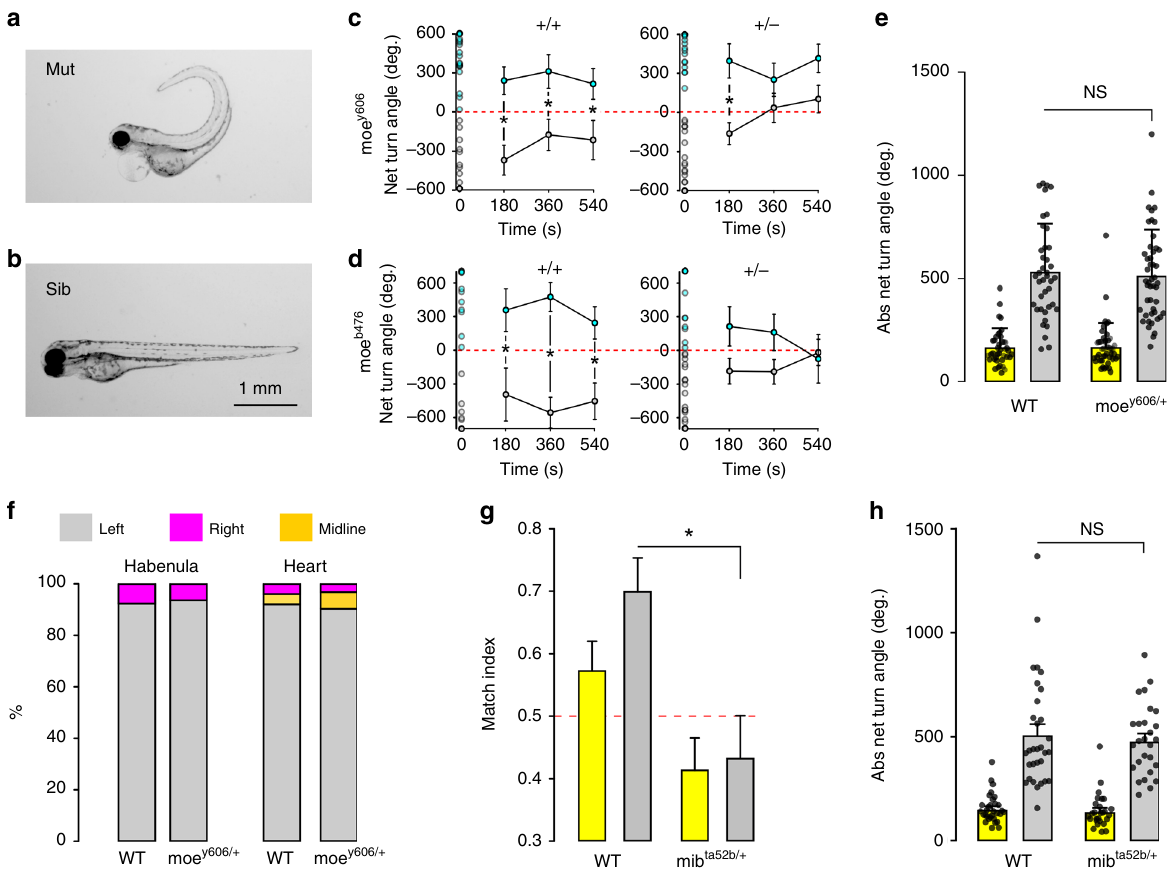
Fig. 6 Left/right identity is disrupted by mutations in genes that regulate Notch signaling. a , b Curly-up morphology in 2-dpf y606 mutant ( a ) and sibling larvae ( b ). c Net turn angle for moe y606 wild-type (left, + / + ) and heterozygous (right, + / − ) sibling larvae over four 30-s light-off trials. Open circles in the fi rst trial (time 0) represent individual NTA for all larvae tested, and were used to classify larvae as right- (cyan, Het N = 20; WT N = 20) or left-biased (black, Het N = 27; WT N = 20). Subsequent points represent mean for left/right groups on trials 2 – 4. Repeated measures ANOVA effect of genotype F 1,81 = 3.8, p = 0.05, η 2 p = 0.05. d Same analysis as in ( c ) for moe b476 allele showing right- (cyan, Het N = 11; WT N = 15) or left-biased (black, Het N = 25; WT N = 9) larvae. Repeated measures ANOVA interaction of genotype/motor-bias F 1,56 = 5.3, p <0.05, η 2 p = 0.09. Asterisk p < 0.05 between groups in ( c , d ). e Absolute net turn angle for moe y606 heterozygous ( N = 47) and wild-type sibling ( N = 40) larvae averaged over four trials for baseline illumination (yellow bar) and light-off (gray bar) trials. f Habenula and heart placement in wild-type siblings and moe y606 heterozygous larvae. Left: percentage of larvae with a larger habenula hemisphere on each side ( N = 32 and 25 for wild type, hets). Right: percentage of embryos with the heart positioned on the left, right, or midline ( N = 25 and 31 for wild type, hets). g , h Match index ( g ) and total turning ( h ) for wild-type siblings and mib ta52b heterozygous larvae ( N = 31 and 27, respectively), during baseline (yellow) and dark (gray) responses. Asterisk p < 0.05, r = 0.42, Mann – Whitney U test. Error bars represent standard error of the mean. Source data are provided as a Source Data fi